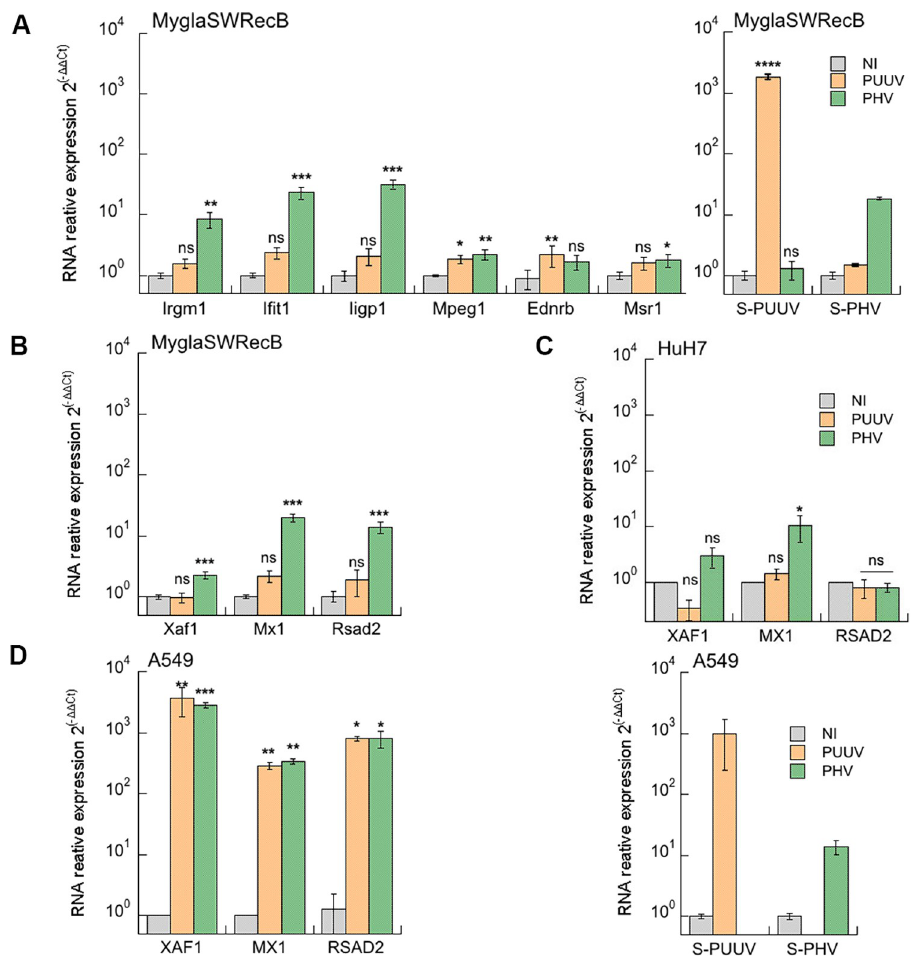
Fig 10. Quantitative RT-qPCR confirmation of gene expression in bank vole cells. In (A), relative differential expression of Irgm1, Ifit1, Iigp1, Mpeg1, Ednrb, Msr1 genes measured by RNA-Seq was validated by RT-qPCR using RNA extracted at dpi5 from MyglaSWRecB that were either not infected (NI, grey bars), or infected with PUUV (orange bars) or PHV (green bars). In (B), the expression of Xaf1, Mx1 and Rsad2, was examined in MyglaSWRecB cells and, the expression in infected HuH7 and A549 cells of their human counterparts RSAD2, XAF1, and MX1 is shown in (C) and (D) respectively. The expression of RNA corresponding to the S segments of PUUV and PHV is shown in the right panels of (A) for MyglaSWRecB and of (D) for A549-infected cells. Error bars correspond to the standard deviation from the mean of samples tested in triplicate and statistical analysis performed as shown in Fig 8.